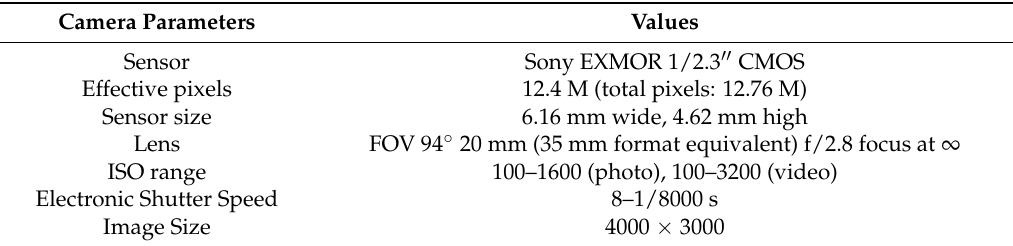
Table 2. Imaging sensor specifications.